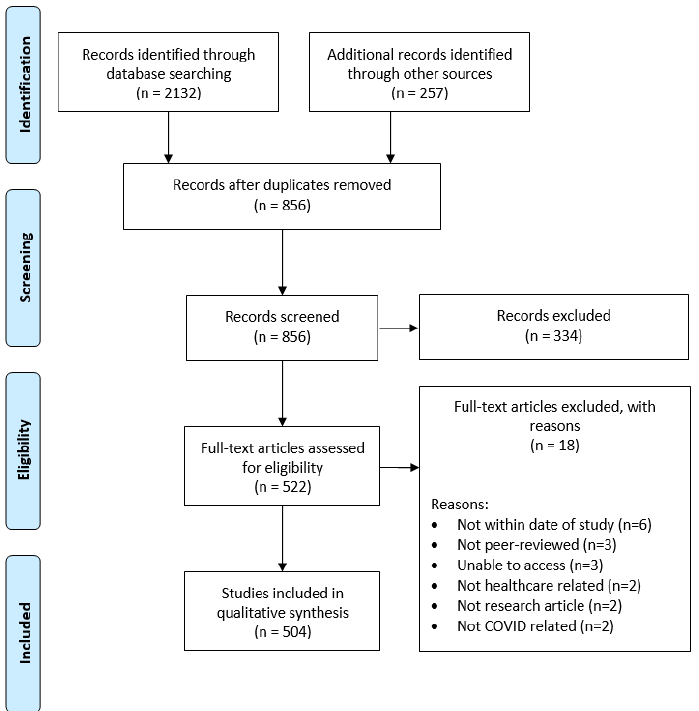
Figure 1. Preferred Reporting Items for Systematic reviews and Meta-Analyses (PRISMA) flow